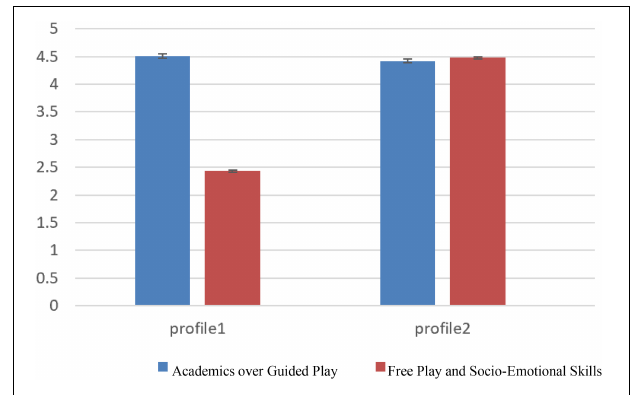
FIGURE 2 | Latent profile analysis results for Teacher’s play beliefs.